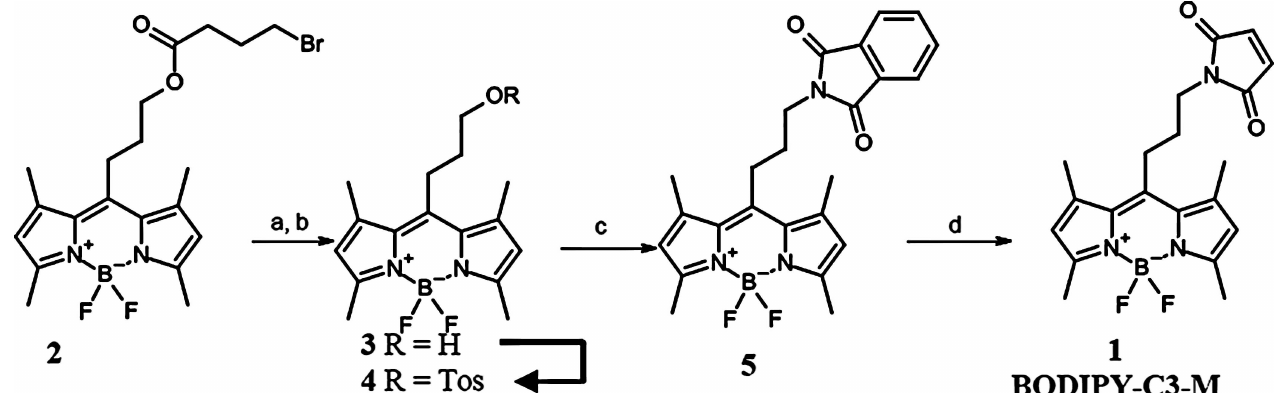
Fig 7. Synthesis scheme for BODIPY-C3-M. a) MeOH/DCM (2:1), LiOH (aq), rt, 4h; b) DCM, tosyl chloride, NEt 3 , DMAP 0˚C, rt; c) Phthtalimide potassium salt, MeCN (5% DMSO), 50˚C, 24 h; d) 1. Hydrazine, EtOH/DCM; 2. DCM, N -methoxycarbonylmaleimide,rt, 52